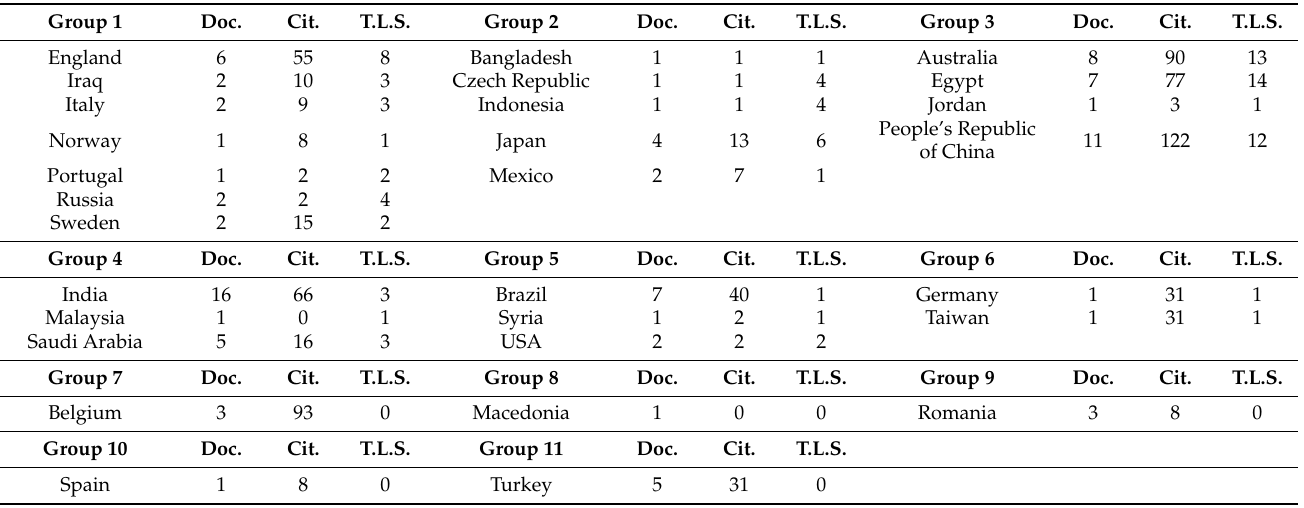
Table 3. Published documents grouped by country. Source: own processing through VOSviewer.